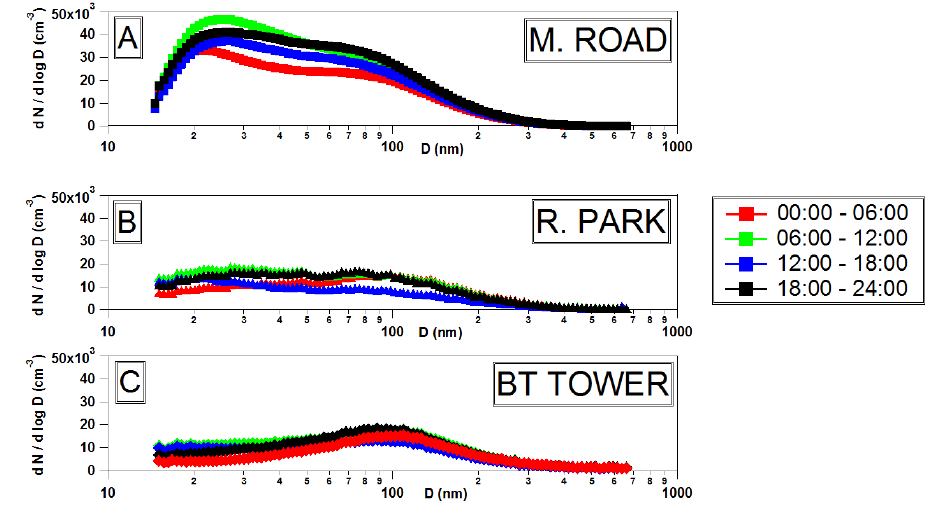
Figure 6 : Same size distributions as in Figure 5, re-drawn for comparison. Average SMPS size distributions taken simultaneously during the REPARTEE-II field study at 6 hours time period at 00:00-06:00, 06:00-12:00, 12:00-18:00 and 18:00-24:00 for (A) M. Road, (B) R. Park and (C) BT Tower.